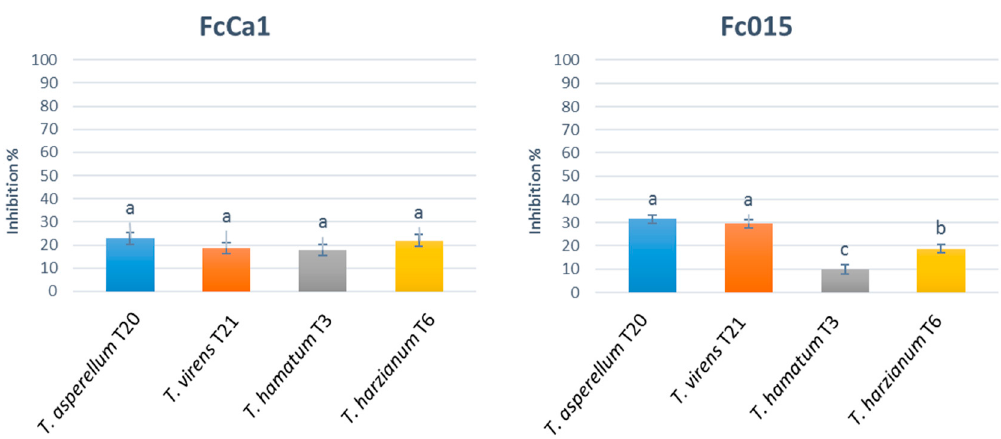
Figure 4. Percent inhibition of F. circinatum (FcCa1 and Fc015) mycelial growth by volatile compounds of Trichoderma spp. Different letters indicate significant differences at p < 0.05, according to Tukey’s post-hoc test. Vertical bars indicate SE.